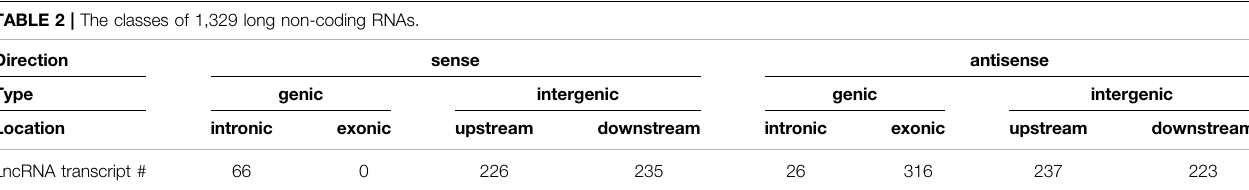
TABLE 2 | The classes of 1,329 long non-coding